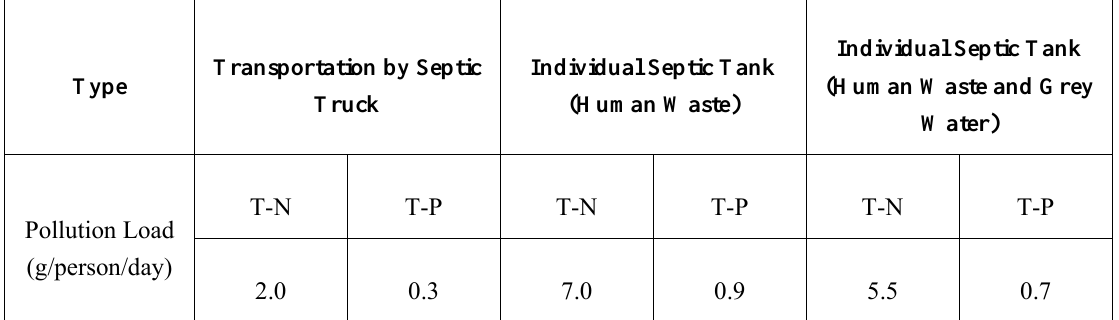
Table 1. Pollution load values of T-N and T-P for the three methods of domestic wastewater treatment. The load values include graywater loads discharged untreated in the ‘Transportation by septic tanks’ and ‘Individual septic tank (Human Waste)’ methods. Pollution load units are drawn from Fujimura [34].